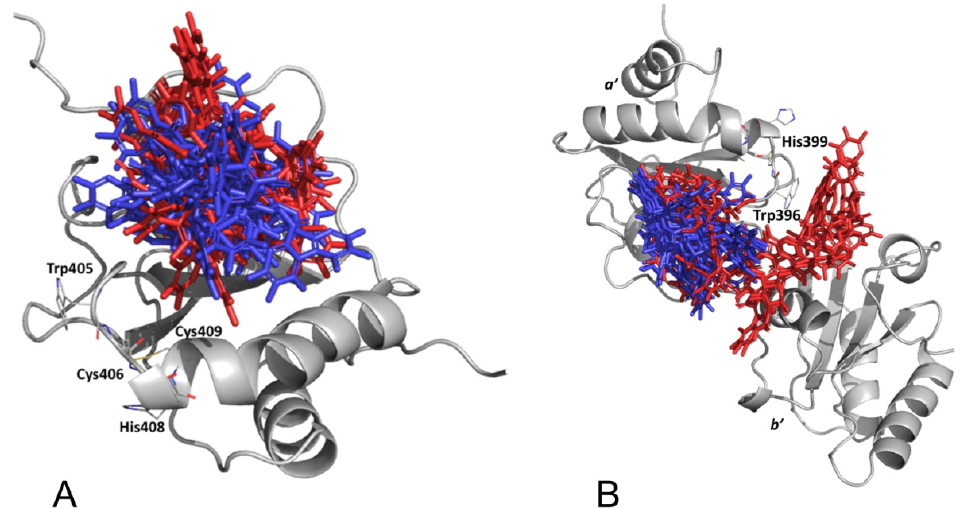
Figure 6. Selected α and β -punicalagin docking results for PDIA 3 ( A ) and PDIA1 ( B ) a’ domain: conformation selected by Vinardo score are depicted in red, while those selected by KDE are blue.